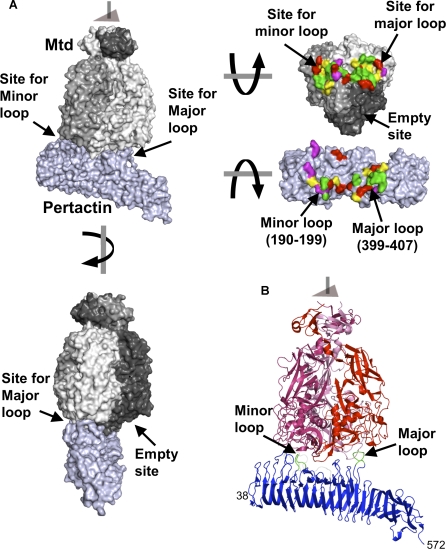
Structure of Mtd-P1 Bound to Prn-E.(A) (Top left) The Mtd-P1·Prn-E complex is depicted in molecular surface representation, with each protomer in the Mtd-P1 trimer colored a different shade of gray and Prn-E colored blue. The trimer axis of Mtd is depicted by a gray triangle at the top. One site of trimeric Mtd binds the major pertactin loop (399–407); a second site binds the minor pertactin loop (residues 190–199); the third site is empty. (Bottom left) Arrow designates a 90° rotation, which exposes the empty site to view. (Top right) Arrows designate 90° rotations (Mtd rotated back toward page, Prn-E forward toward viewer) that expose the interacting surfaces to view (green, hydrophobic contacts; red, hydrophilic contacts; yellow, hydrophobic buried; purple, hydrophilic buried). Contact residues are those having an interatomic distance between Mtd-P1 and Prn-E of ≤4 Å, and buried residues are those having an interatomic distance of >4 Å and excluding water due to association.(B) The Mtd-P1·Prn-E complex is depicted in ribbon representation (Mtd protomers in red, pink, and purple and Prn-E in blue). Prn-E loops that contact Mtd-P1 are green and labeled. The trimer axis of Mtd is depicted by a gray triangle at the top. For reference, the RGD loop of pertactin is shown in light gray in the conformation observed for B. pertussis pertactin [12] but was not modeled in the structure of the Mtd-P1·Prn-E complex.